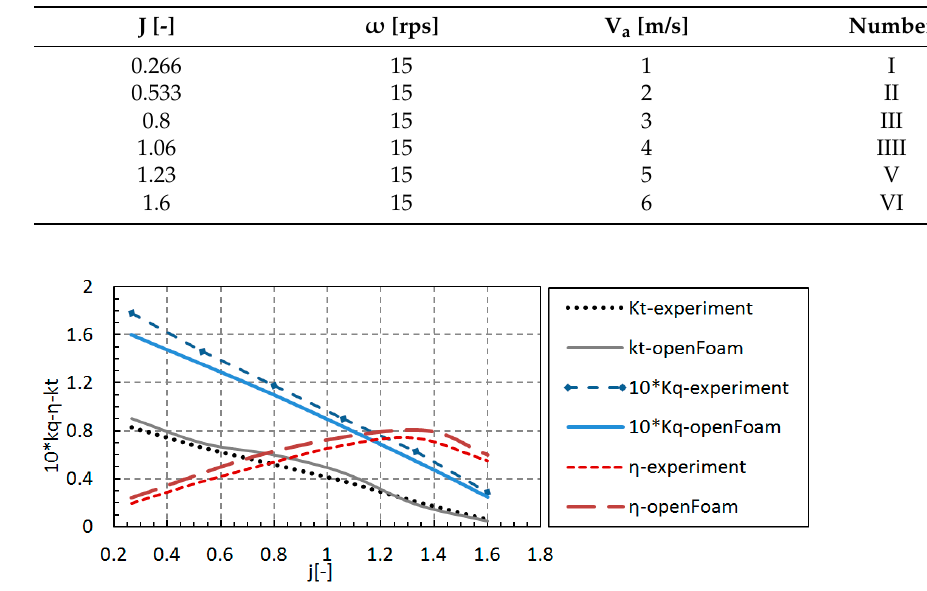
Figure 3. Hydrodynamic comparison between experimental and numerical results. Table 5. Different advance coefficient specifications.